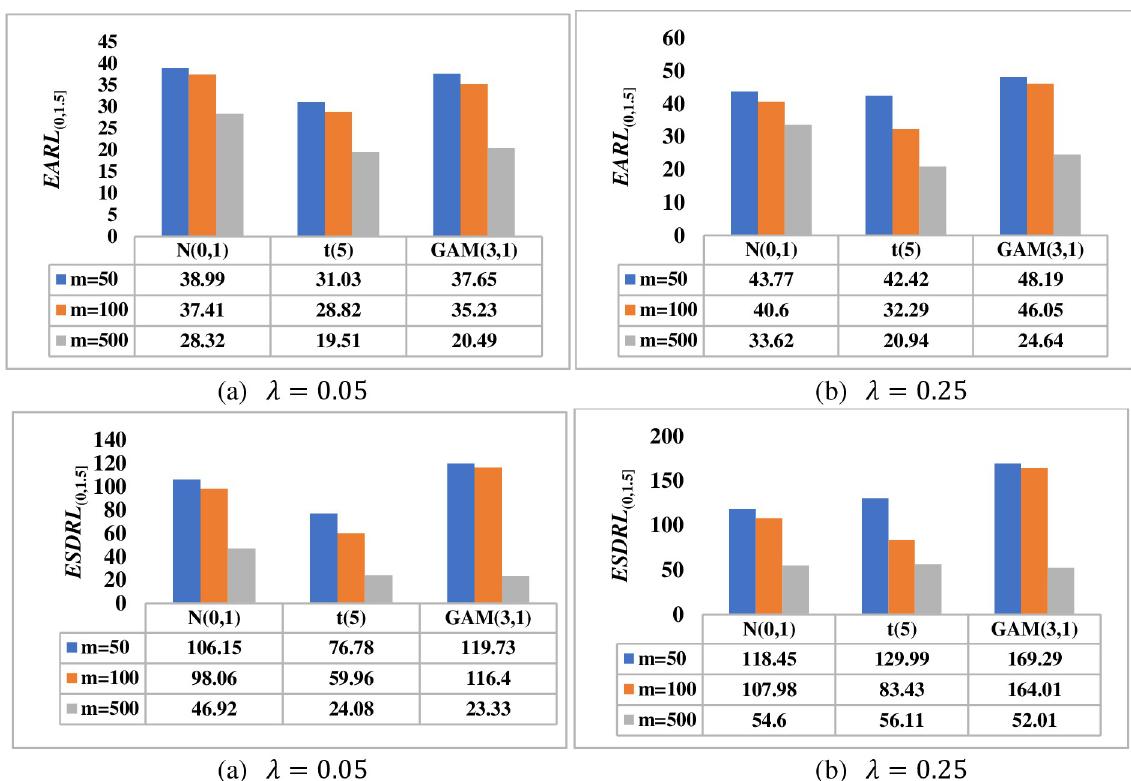
Fig 2. Effect of the phase I sample size on the performance of HWMA W scheme when n = 5, λ 2 {0.05, 0.25} and m 2 {50, 100,500} under N (0,1), t (5) and GAM (3,1)